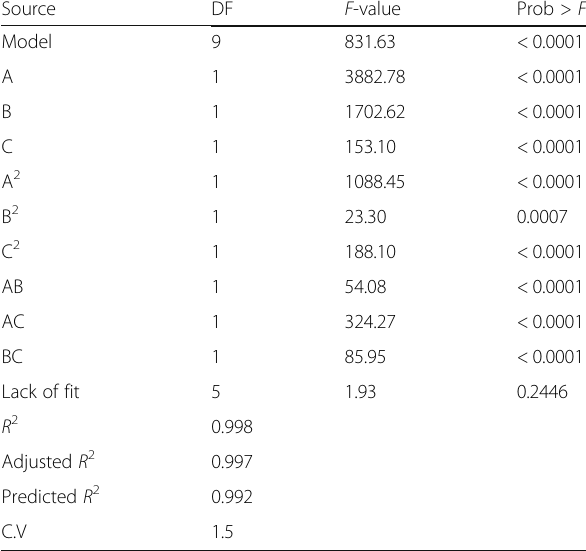
Table 2 ANOVA results for the quadratic model Source